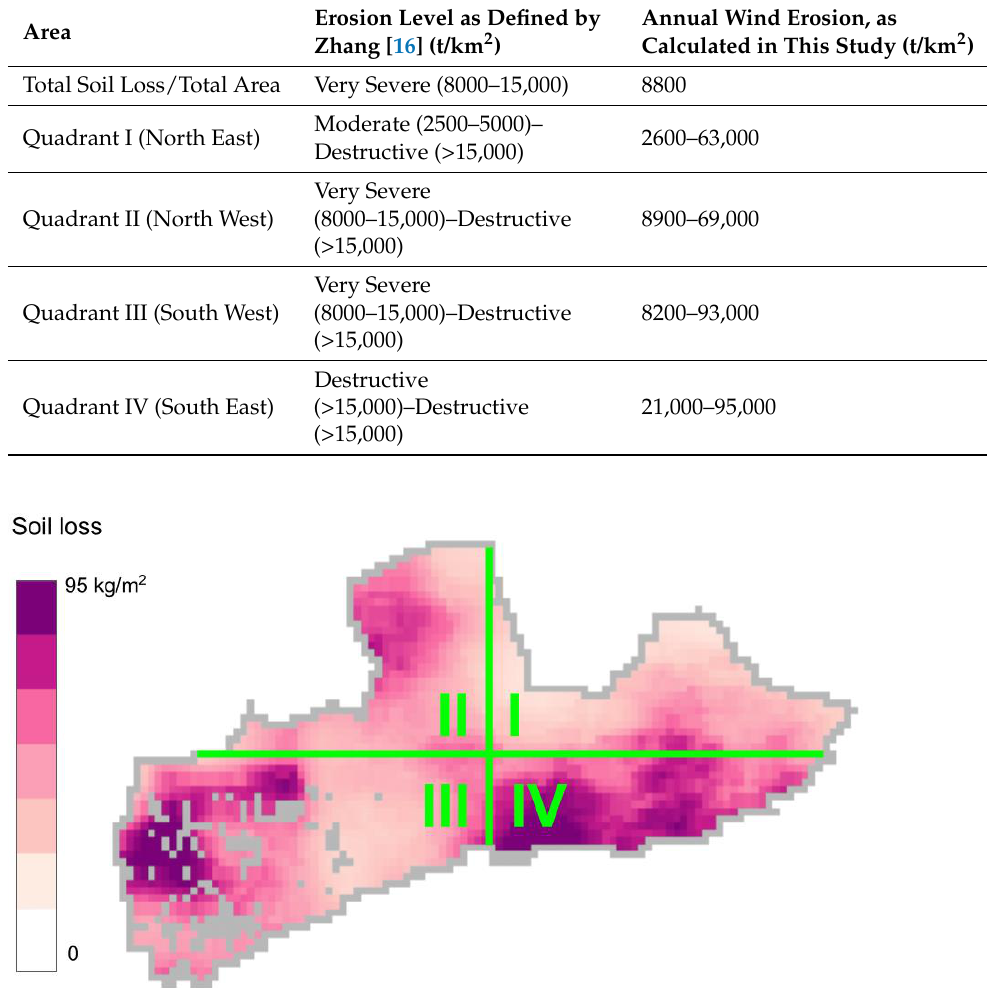
Figure 3. Map of annual soil erosion in our area of interest split into four quadrants corresponding with rows of Table 3. For each quadrant, the spatial maximum and minimum soil erosion are represented as categories according to Zhang [16].